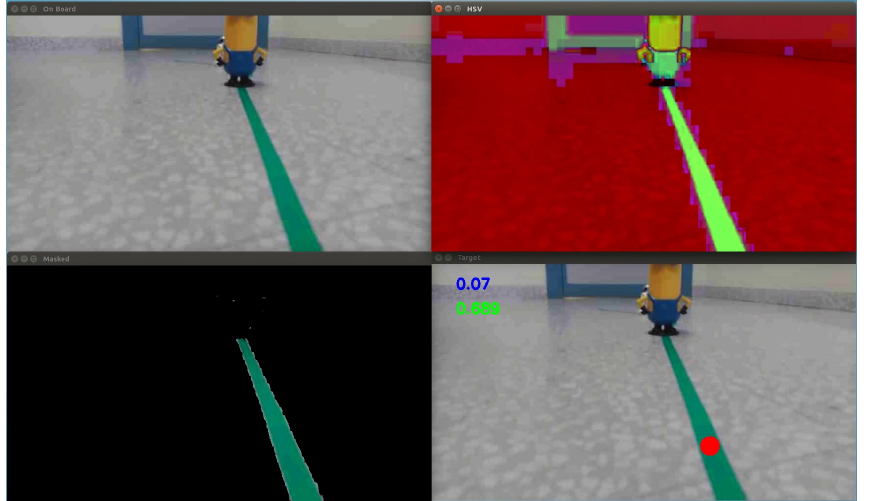
Figure 8. Control screen showing the different stages (from top to left): original image from Android camera; image in HSV framework; original image masked with the detected line; and original image with the selected target point marked on the line.